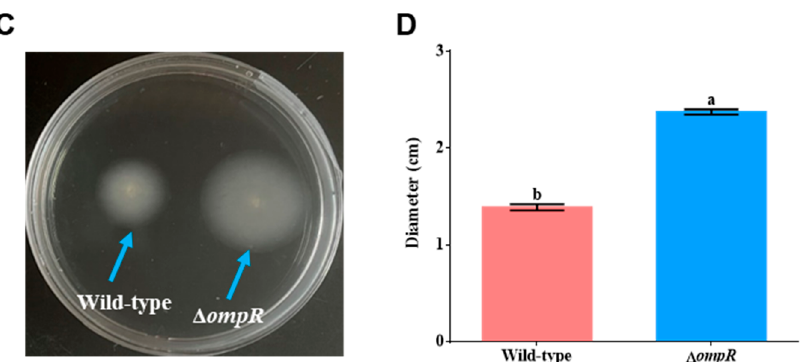
Figure 2. The growth ability, colony morphology ( × 50), and bacterial motility of wild-type and strains. ( A ) Colony morphology of wild-type and ∆ ompR strains; ( B ) growth curve of wild-type and Δ ompR strains. ( A ) Colony morphology of wild-type and Δ ompR strains; ( B ) growth curve of wild- ∆ ompR strains (n = 3); ( C ) swimming motility of wild-type and ∆ ompR strains; and ( D ) migration type and Δ ompR strains (n = 3); ( C ) swimming motility of wild-type and Δ ompR strains; and ( D ) zone diameter of wild-type and ∆ ompR strains. Asterisks indicate significant differences ( p < 0.05); migration zone diameter of wild-type and Δ ompR strains. Asterisks indicate significant differences ( p < 0.05); different letters indicate significant differences ( p < 0.05). different letters indicate significant differences ( p < 0.05).